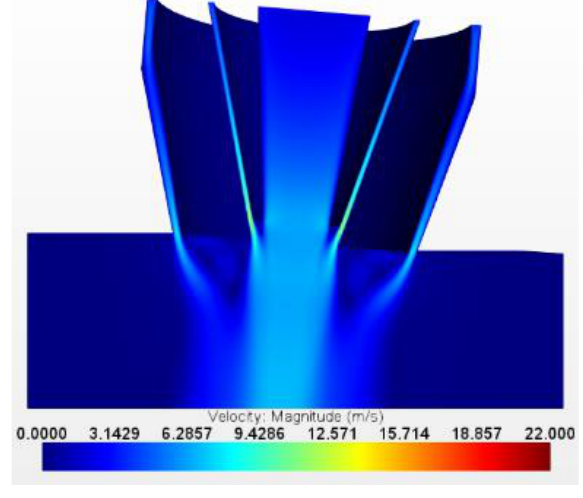
Figure 6: Simulation using condition